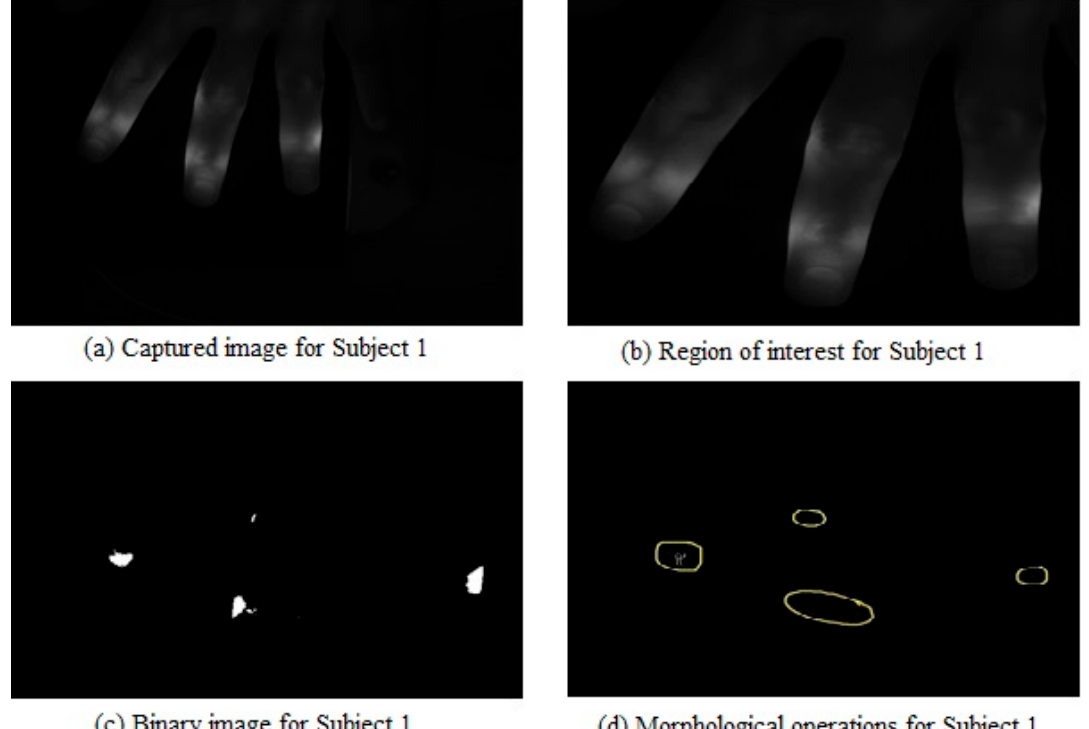
Figure 3. Images for Subject 1.